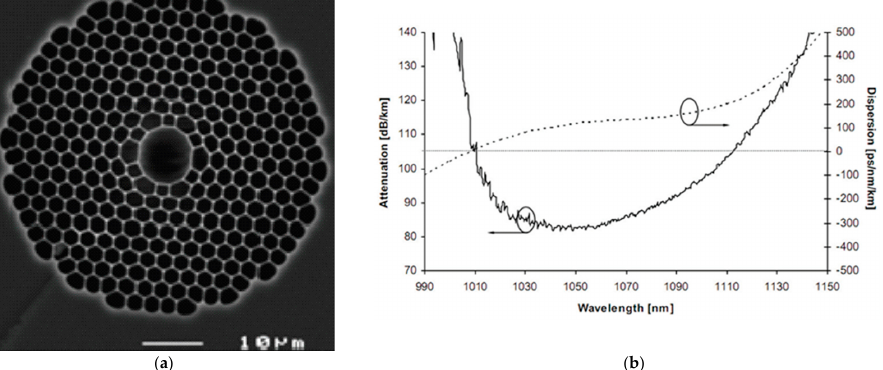
Figure 3. ( a ) The schematic cross section of the HC-PCF and ( b ) the transmission loss and dispersion curves of the HC-PCF, both from the product manual provided by NKT Photonics.